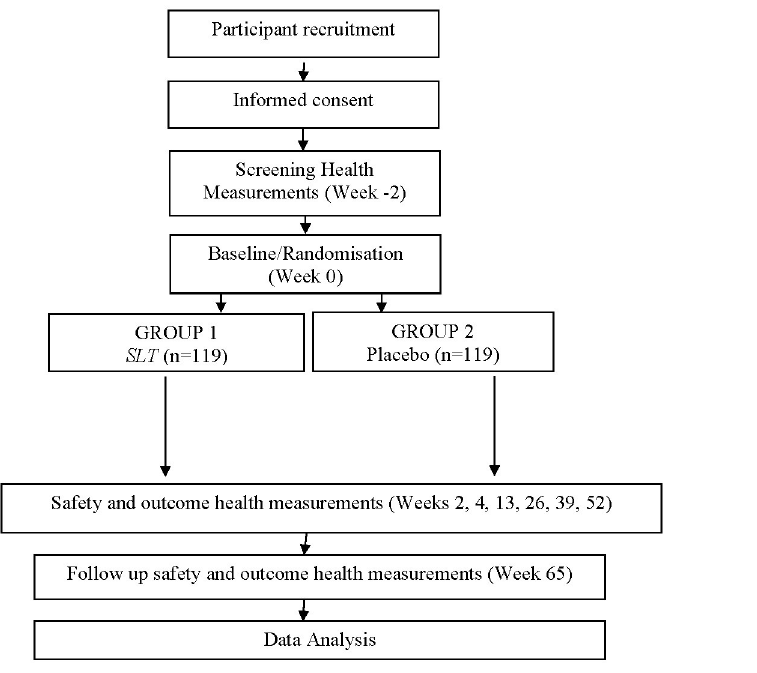
Fig 2. Schematic of the trial